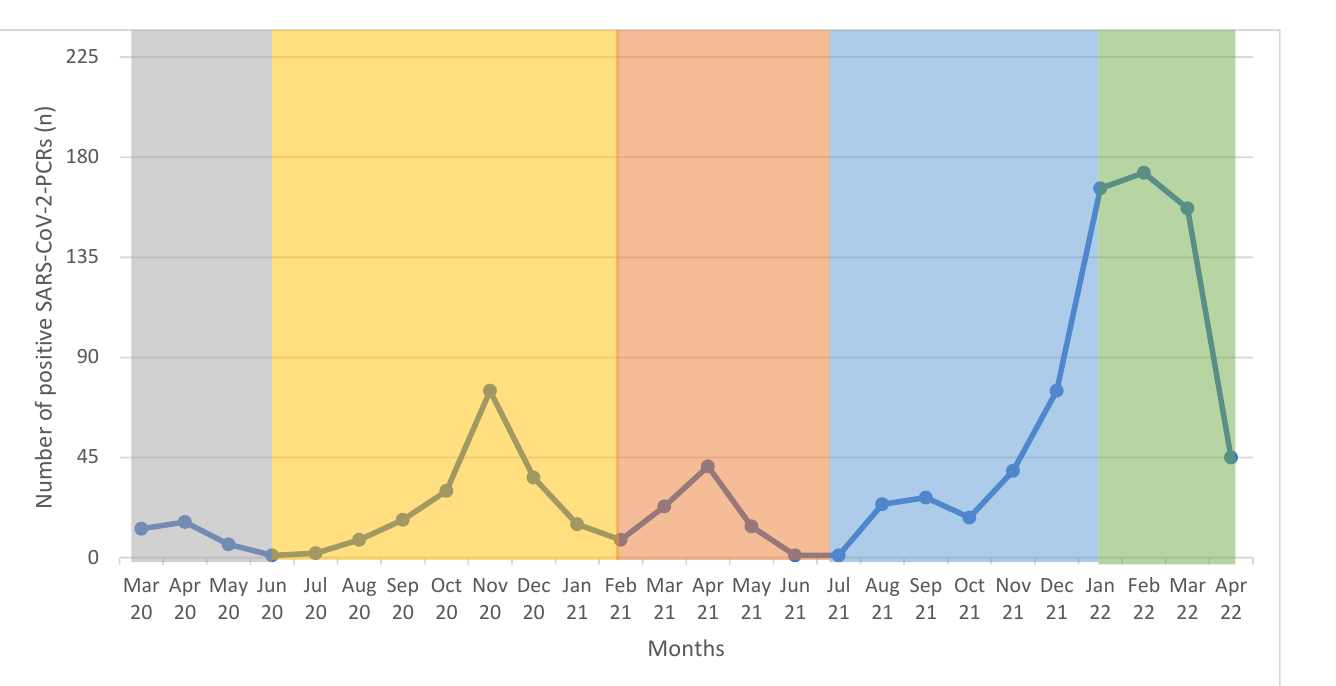
Figure 1. Number of positive SARS-CoV-2-NAATs between 13 March 2020 and 22 April 2022 ( n = 1028): grey = first wave, yellow = second wave, red = third wave, blue = fourth wave, and green = fifth wave .